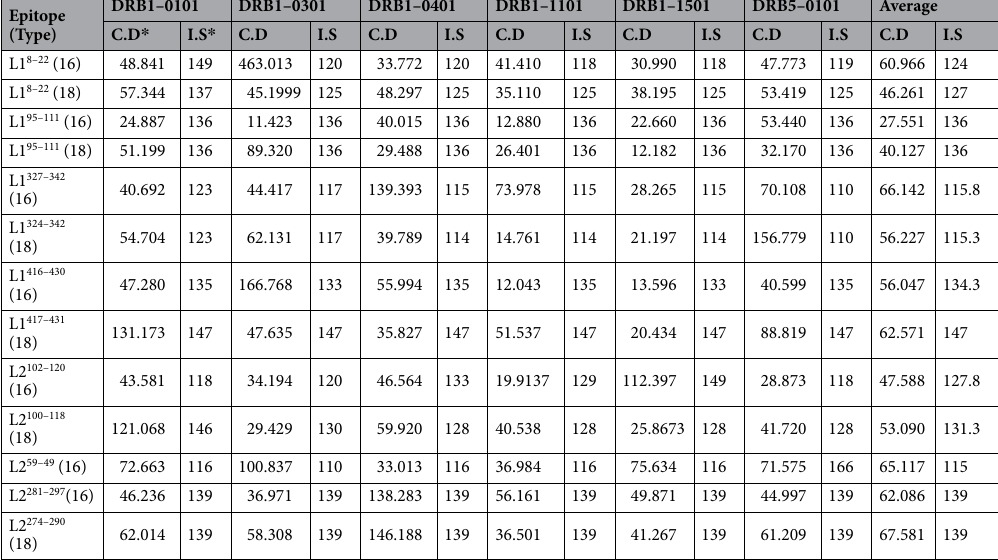
Table 12. MHC-II -peptide docking scores of selected helper T-cell epitopes. * higher rate shows better quality of peptide-MHC interactions.